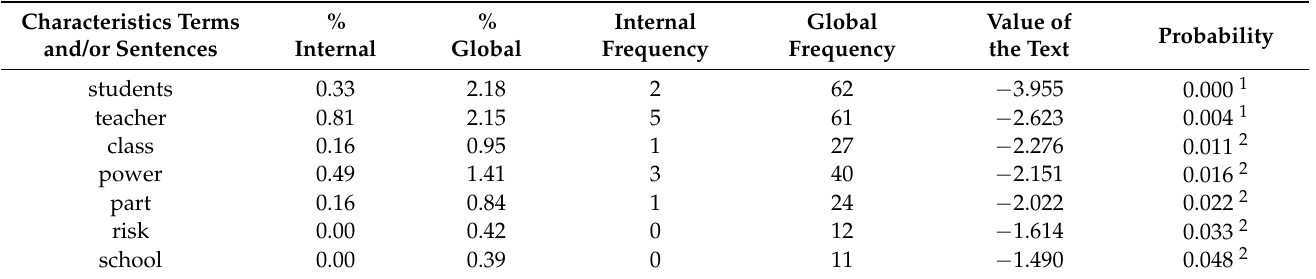
Table 2. The words less used by the teachers in answering to the question: “What is, in your opinion, the cause of school drop-out?”.